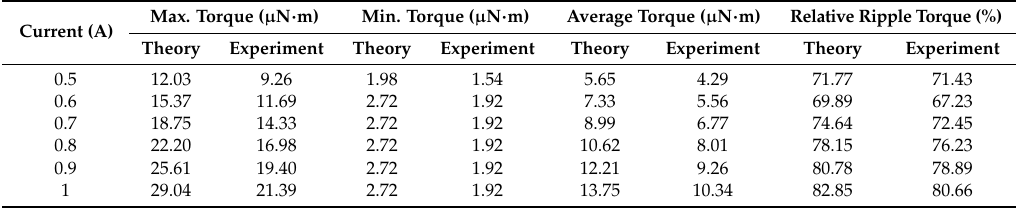
Table 6. Comparisons of theoretical and experimental torque characteristics of the single-phase switched reluctance motor.